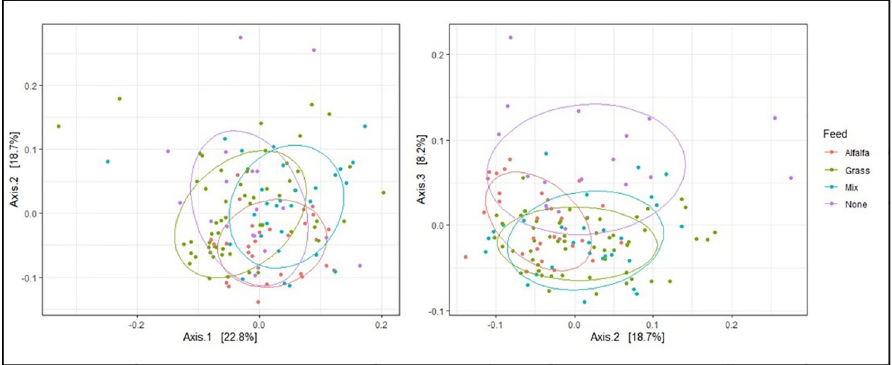
Fig 3. Principal coordinate analysis of cross-sectional elk gut microbiomes sampled from 13 locations, including 11 feedgrounds stratified among three different feed types and two unfed control groups. The left panel shows the first two principal coordinate axes, and the right panel shows the second and third axes. Collectively, the first three axes explained 49.7% of the variance among samples. Ellipses are drawn around 70% of the data points in each feed